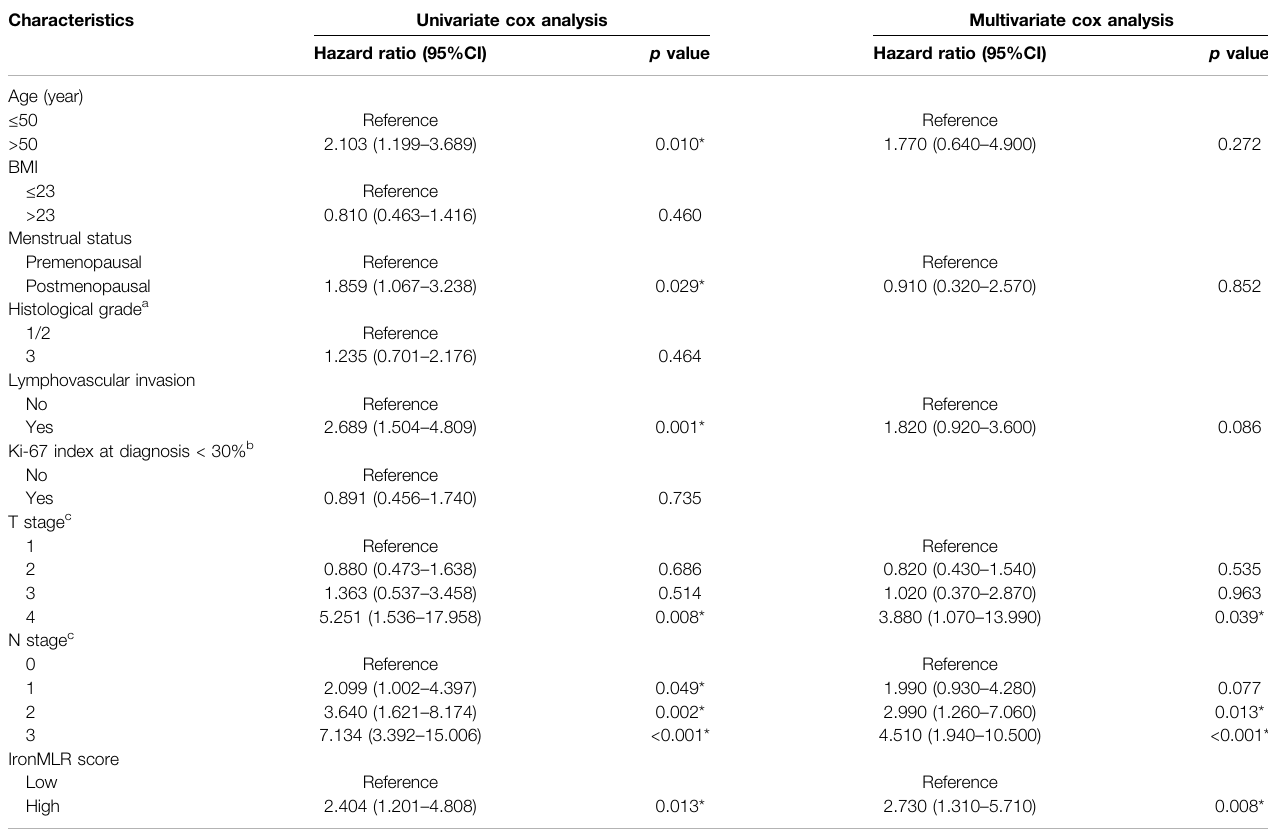
TABLE 3 | Univariate and multivariate cox regression analysis of overall survival.